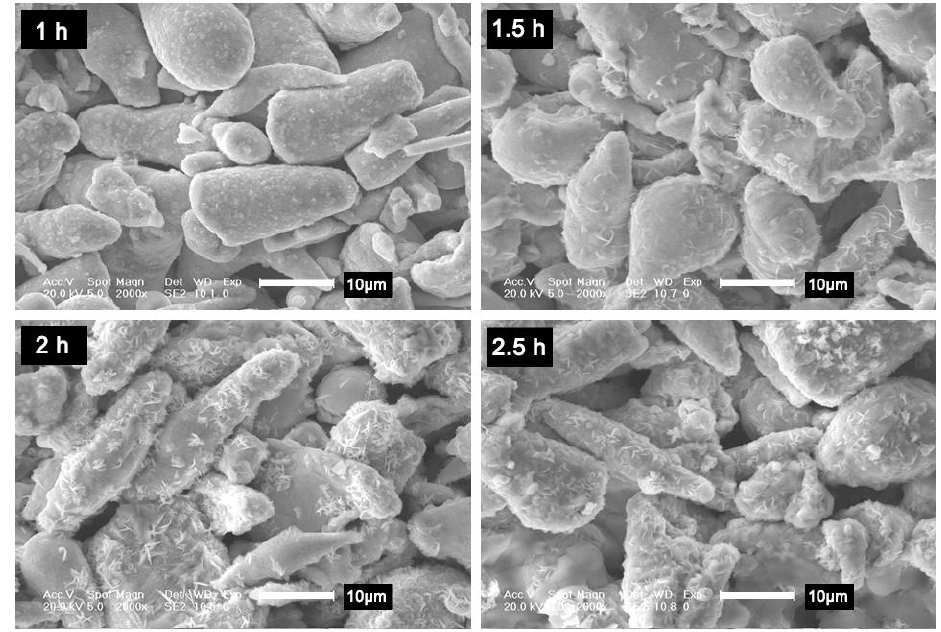
Figure 12. SEM images of sintered parts for different holding times (magnified 2000 times).